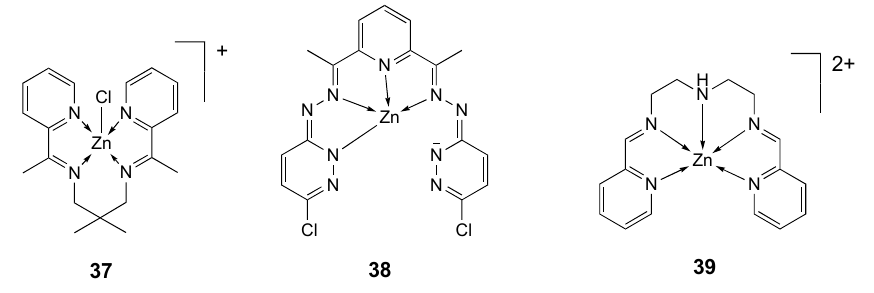
Figure 20. Structure of the zinc complexes 37 – 39 .